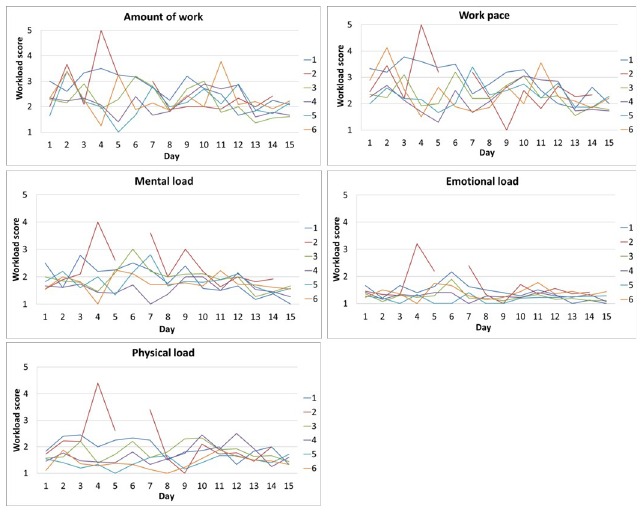
Fig 3. Five line graphs with average perceived workloads per ward per day for amount of work, work pace, mental load, emotional load and physical load.